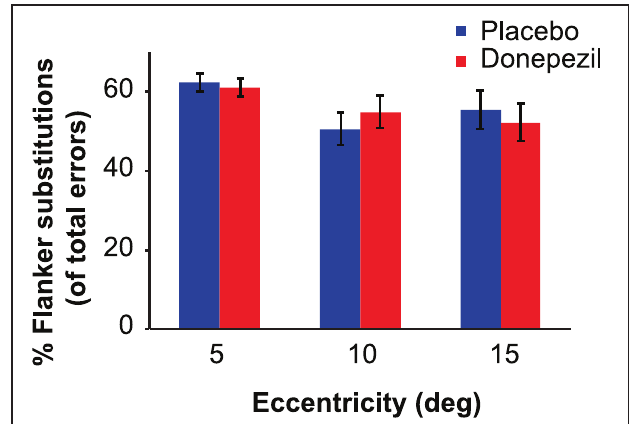
FIGURE 6 | Flanker substitution errors (expressed as percentage of total errors) in the crowding task. Flanker substitution errors occur when the subject reports the identity of one of the two flanker letters instead of the target letter. Donepezil had no significant effect on the probability of flanker substitution errors at any eccentricity. Error bars represent ± 1 SEM of the within-subject difference between the placebo and donepezil conditions at each